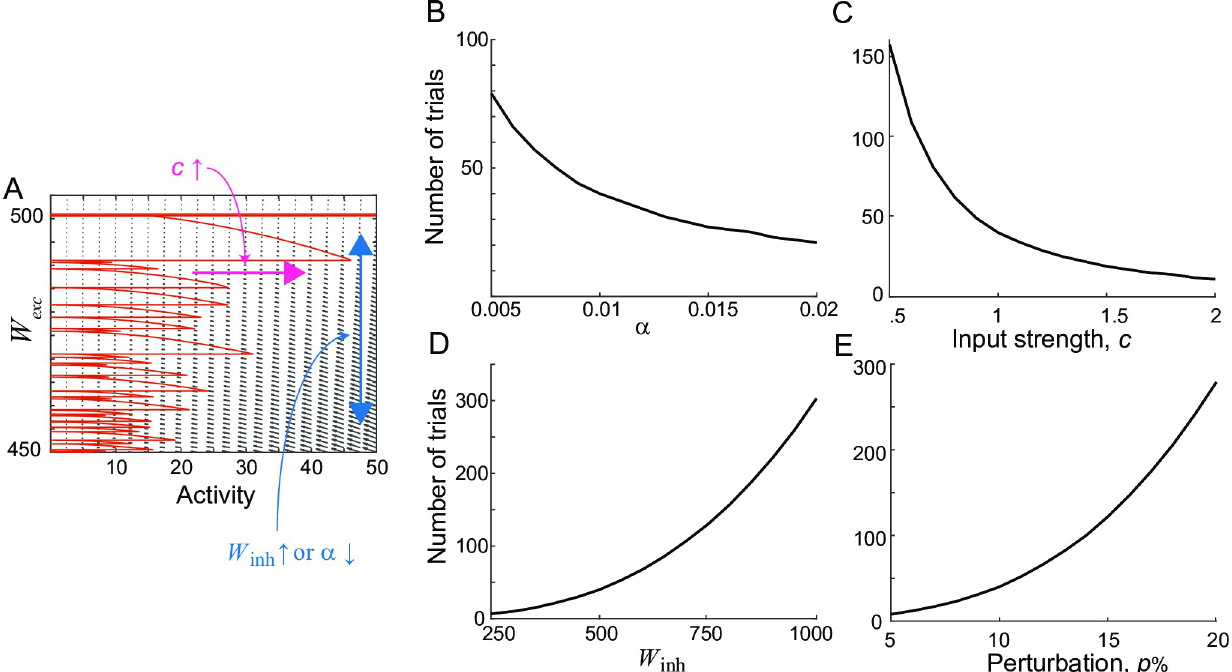
Fig 2. Recovery dynamics dependence on learning parameters under differential plasticity. A: Phase-plane of activity r and synaptic strength of recurrent excitation W . The small black arrows represent a vector field for the dynamics of r and W , described in Eq 2. The red curve is a trajectory exc exc starting from 10% perturbation in W , that is, W = 0.9 W with W = 500. During the stimulus presentation, the trajectory jumps horizontally, and exc exc inh inh input strengths vary randomly across trials. The big arrows indicate the effects of changing the learning speed α or W inh (blue vertical) and relative mean input strengths c (magenta horizontal). B-E: Dependence of recovery speed on learning and network parameters. The minimum number of trials for W exc to reach up to 0.99 W inh , that is, about 1% from perfect tuning was obtained by varying α (B), c (C), W inh (D), perturbation strength p (E). All parameters change from 50% to 200% of those used in Fig